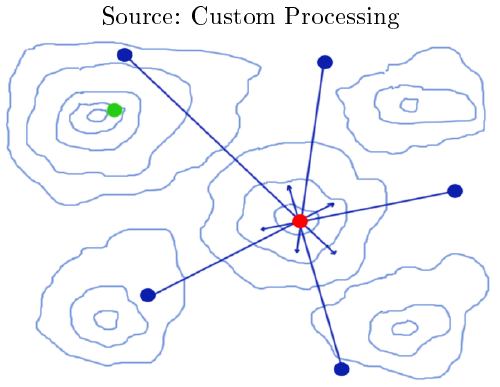
Fig. 8: Global Leader prevents sti(cid:30)ng in local extreme Source: Custom graphics